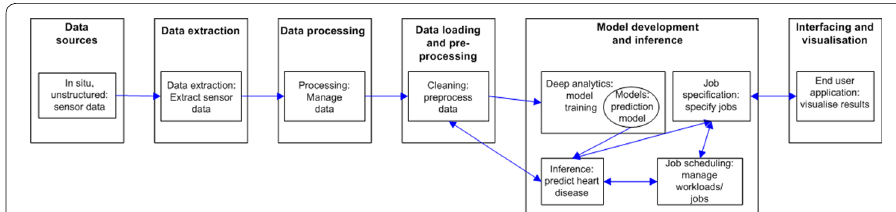
Fig. 21 The mapping of HealthFog [46] to the big data RA